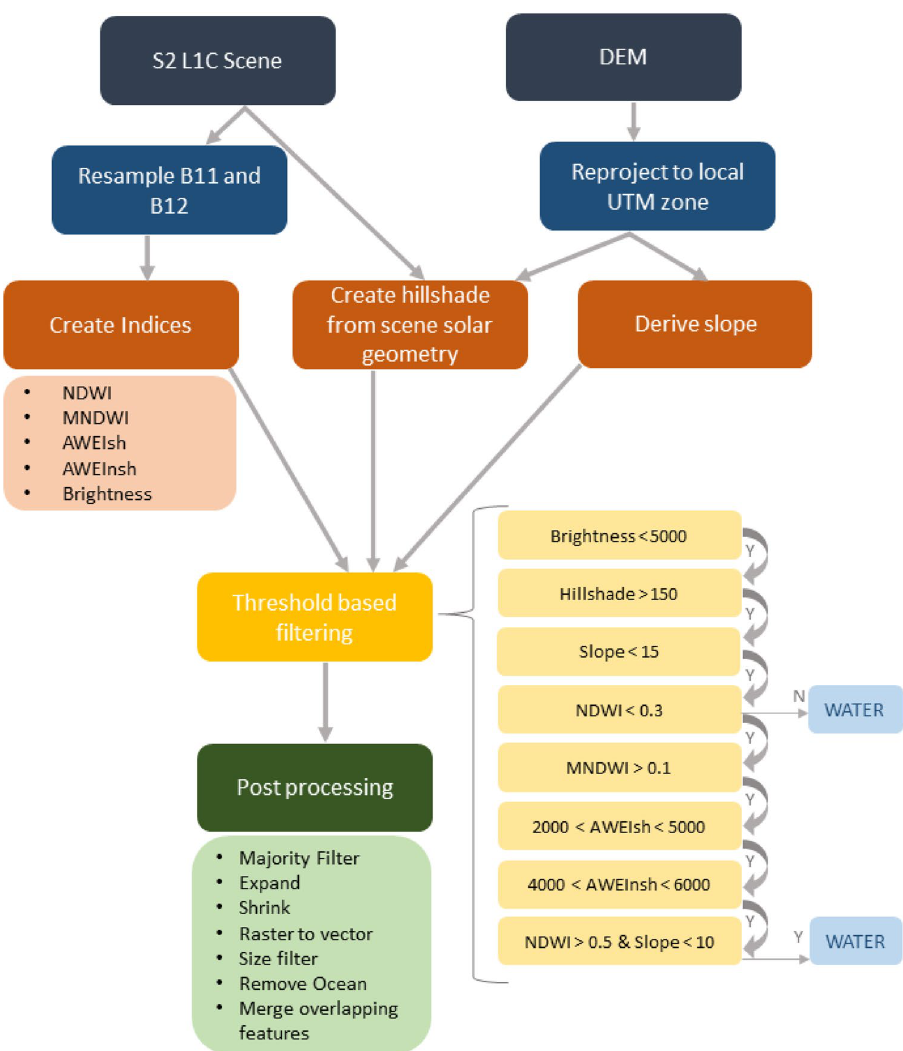
Figure 6. Flow diagram presenting the processing chain for classifying ice marginal lakes from Sentinel-2 imagery, including terrain indices generation using a DEM and multi-spectral indices thresholding, which is compiled through a decision tree classifier to extract water bodies.